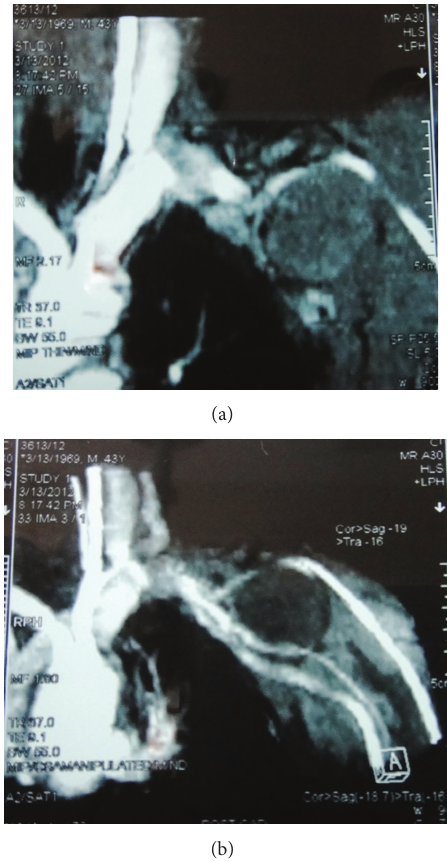
Figure 1: Coronal MRI T1W with gadolinium (a) and (b) images showing a well-defined brachial plexus desmoid tumour that was isointense to muscle on T1W sequences and mixed signal intensity (both low to high signal intensity) on T2W sequences and was straddling the brachial plexus.